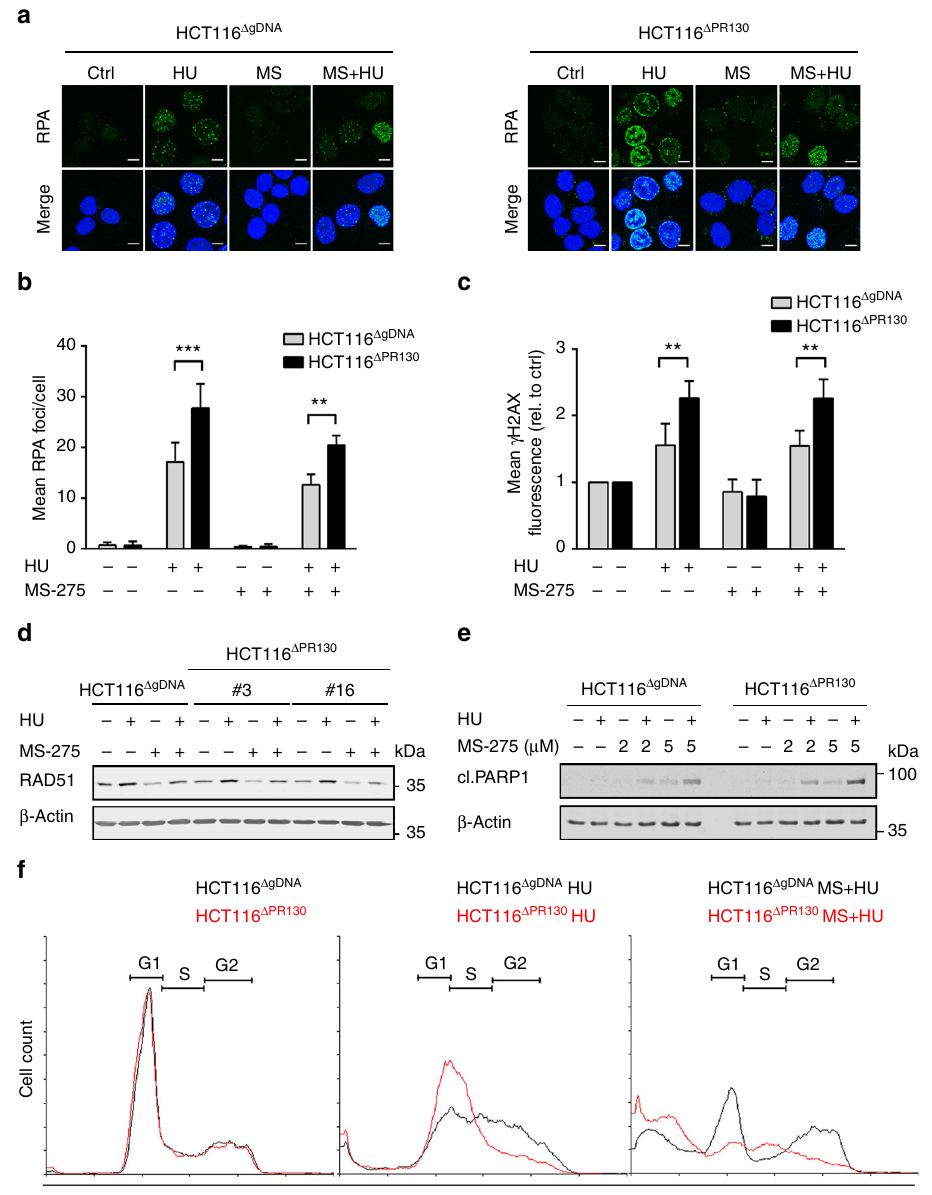
Fig. 8 PR130 in fl uences cell fate decisions. a HCT116 Δ gRNA (upper panel) and HCT116 Δ PR130 (clone #16; lower panel) cells were incubated with 1 mM hydroxyurea (HU) and 2 µ M MS-275 for 24 h. Cells were fi xed and incubated with RPA-speci fi c primary and Alexa Fluor-488-coupled secondary antibody. TO-PRO3 was used to visualise nuclei. Representative images are shown; scale bar, 10 µ m. b Analysis of RPA foci per cell using ImageJ software. Treatment and staining were performed as described in a . Data presented as mean ± SD ( n = 3; two-way ANOVA; ** P < 0.01; *** P < 0.001). c Quanti fi cation of mean ɣ H2AX fl uorescence per cell using ImageJ software. At least 50 nuclei per treatment were analysed. Cells were treated with MS-275/HU for 24 h. Results were normalised to untreated controls. Data represent the mean ± SD ( n = 3; two-way ANOVA, ** P < 0.01). d Western blot analysis of HCT116 Δ gRNA and two HCT116 Δ PR130 clones after 24 h treatment with 1 mM HU and/or 2 µ M MS-275. RAD51 and β -Actin were detected using immunoblot. e Cells were treated with 1 mM HU and 2 – 5 µ M MS-275 for 24 h. Whole-cell lysates were analysed for PARP1 cleavage (cl. PARP1) by western blot. β -Actin served as loading control. f Treatment with HU (1 mM) and/or MS-275 (2 µ M) was carried out for 40 h in both HCT116 Δ gRNA (black) and HCT116 Δ PR130 (clone #3; red). Cell cycle analyses were performed with fl ow cytometry and representative histograms are shown ( n =